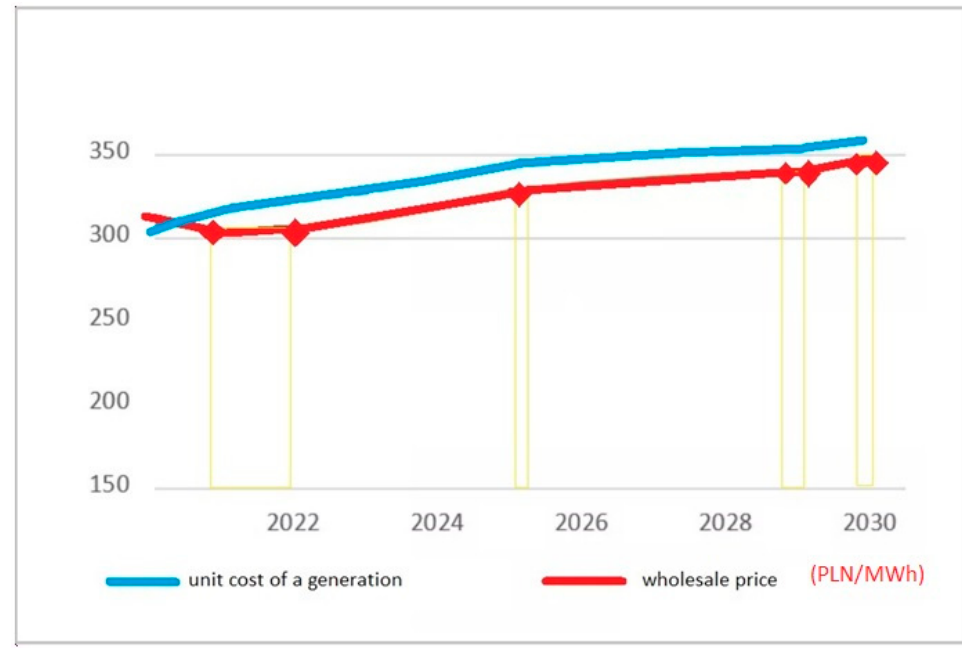
Figure 24. Forecast of electricity generation costs and prices until 2040 in Poland (PLN/MWh) [71].